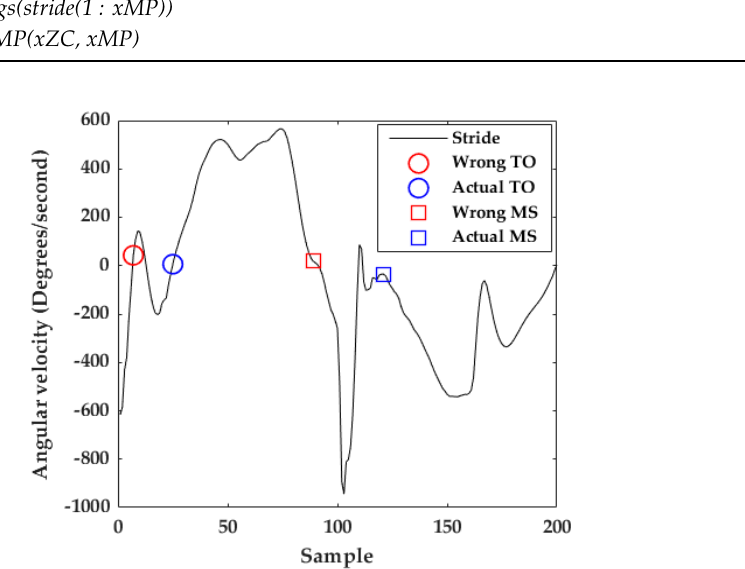
Figure 8. Example of TO and MS detection. The red circle and square show a wrong TO and MS detection, respectively, using the previous TO detection algorithm. The blue circle and square show an adequate TO and MS detection, respectively, using the proposed algorithms. Algorithm 1: Toe-off (TO) detection algorithm.